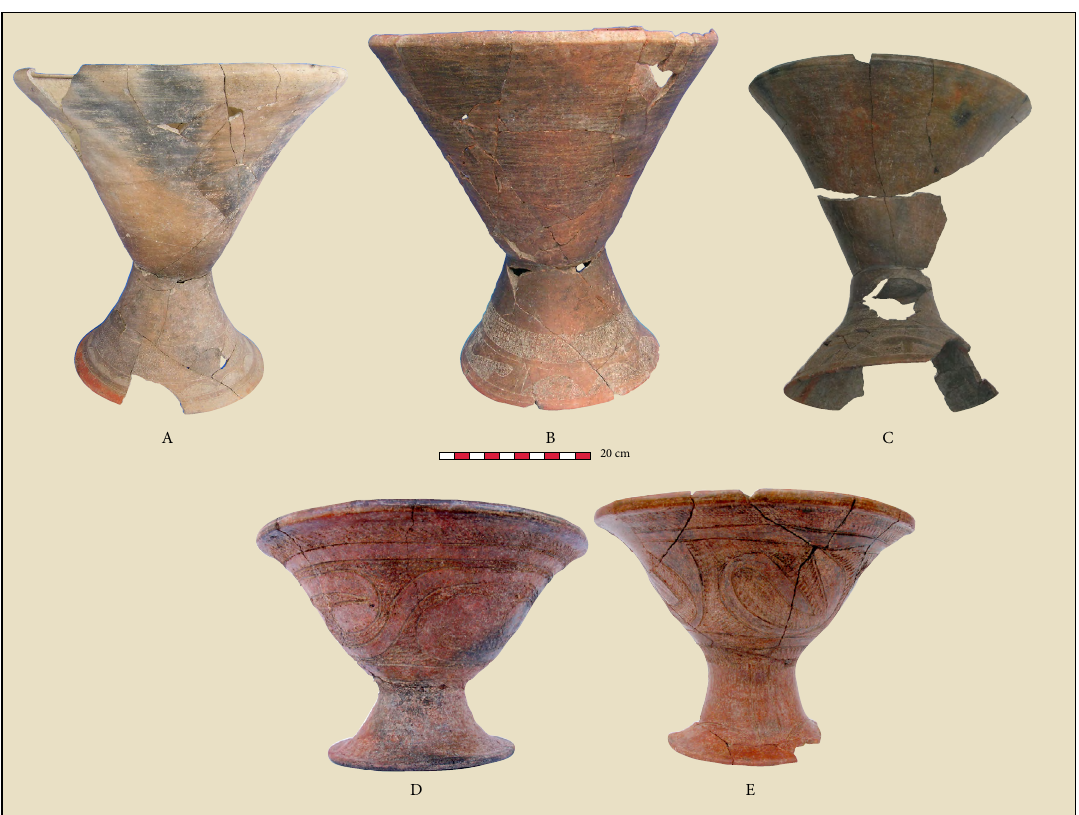
Fig. 3: Stemmed bowls with incised and impressed decoration from Ban Non Wat (A-C) and Tha Kae